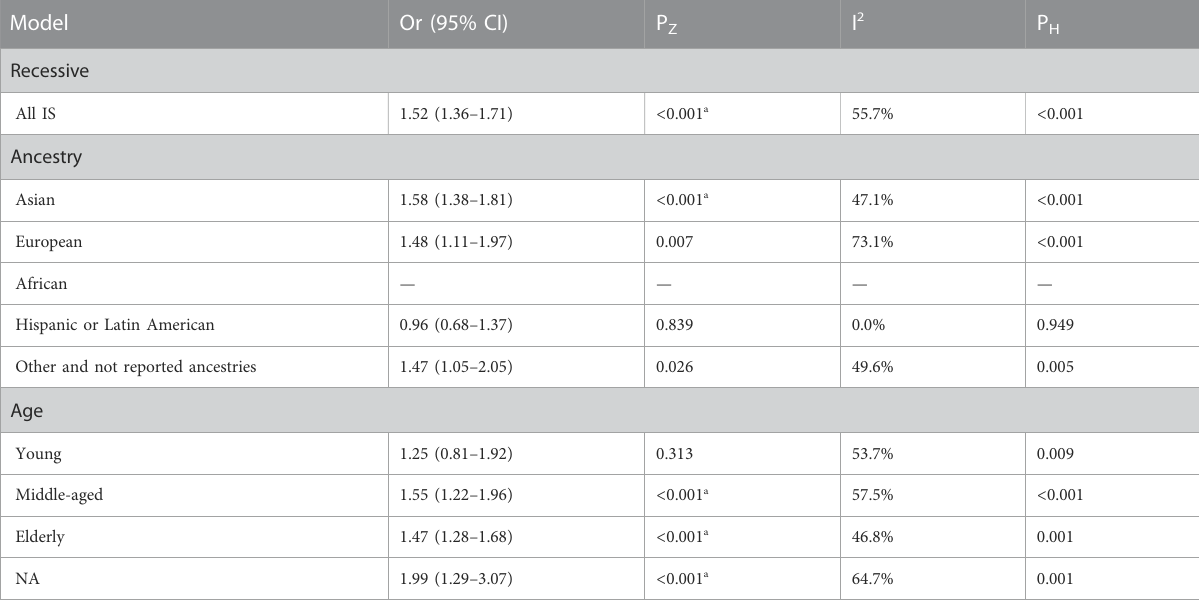
TABLE 3 Pooled odds ratios (ORs) and 95% con fi dence intervals (CIs) of the association between C677T polymorphism and stroke in the recessive model.